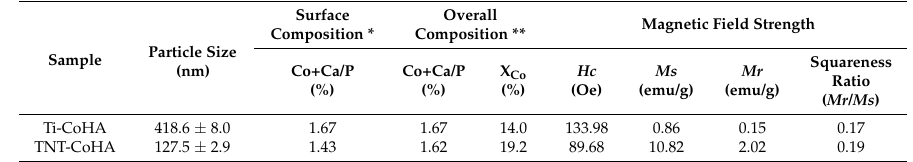
Table 1. The particles size, composition, and magnetic analysis of Ti-CoHA and